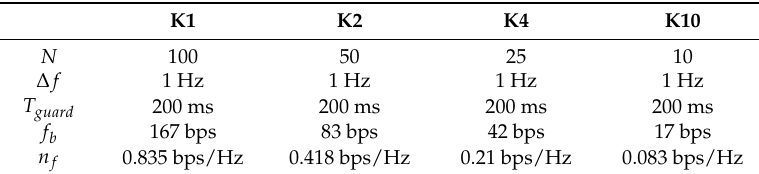
Table 2. The parameters of FM-OFDM-QPSK numerical models for the central frequency of 400 Hz and bandwidth of 200 Hz. K1 K2 K4